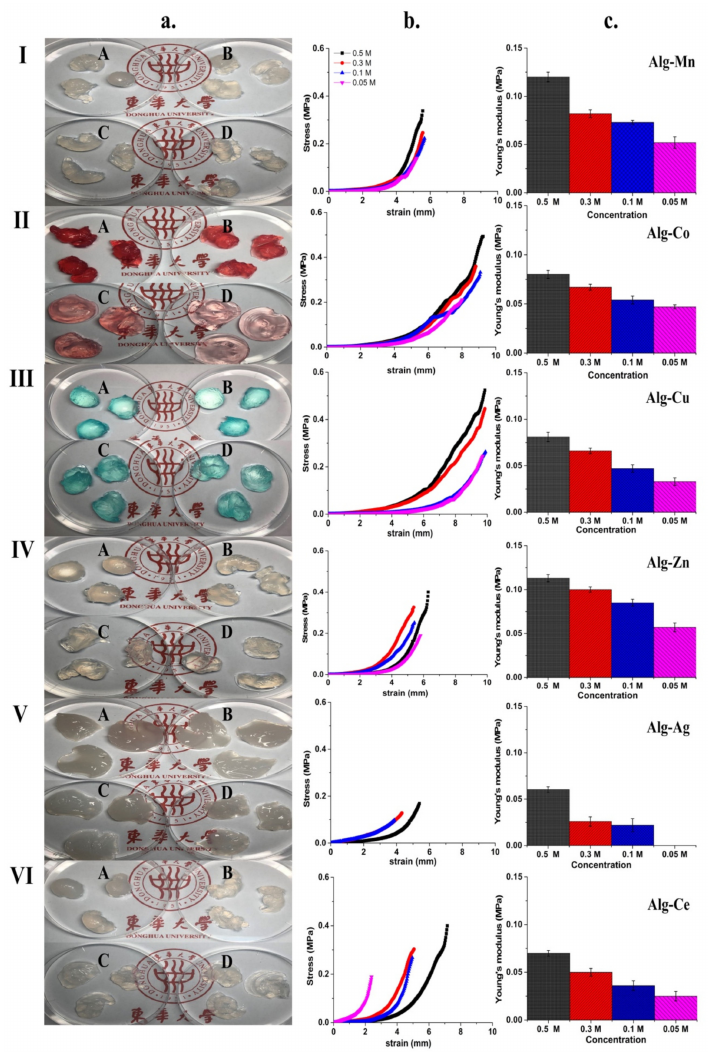
Figure 1. ( a ) Morphology of hydrogels of (I) Alg-Mn, (II) Alg-Co, (III) Alg-Cu, (IV) Alg-Zn, (V) Alg-Ag, and (VI) Alg-Ce at cationic concentrations of (A) 0.5, (B) 0.3, (C) 0.1 and (D) 0.05 M, as well as ( b ) corresponding compressive strength and Young’s modulus of hydrogels ( c